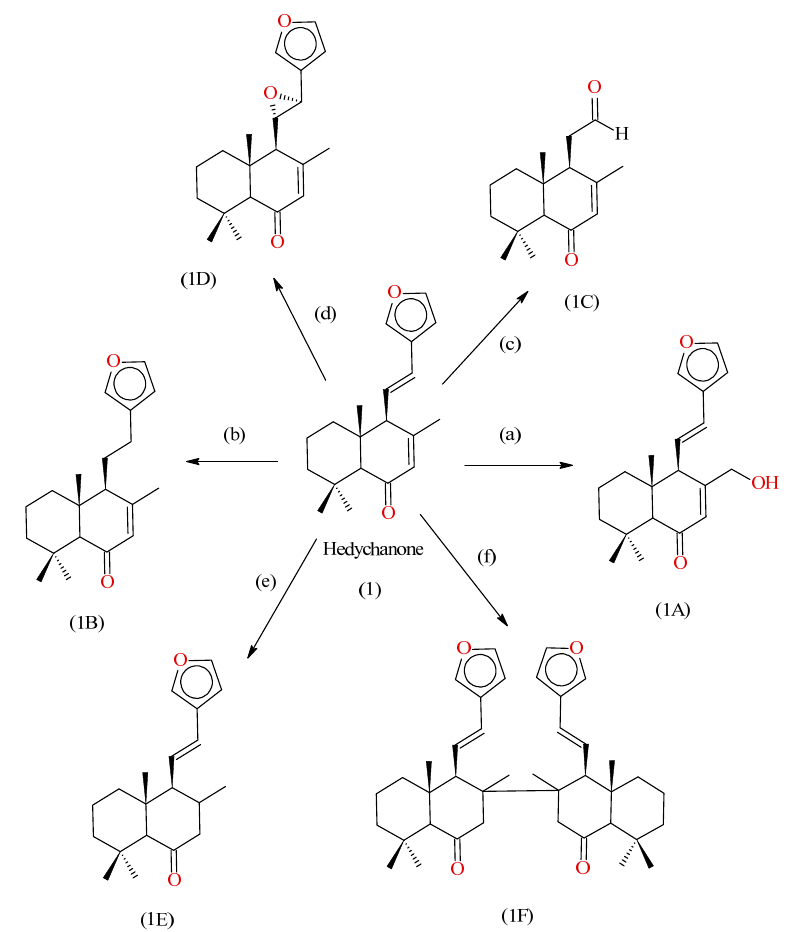
Figure 7. Synthesis of compounds from Hedychenone, reagents and conditions, where (a) SeO 2 , dry Dioxane/reflux, 70 ◦ C, 1 h, 94%; (b) (1) Pd/C (10%), EtOH, 1 h; (2) LiAlH 4 , THF, 0 ◦ C, 4 h, 50%; (c) O 3 , CH 2 Cl 2 , 10 ◦ C, 4 h, 55%; (d) m-CPBA, CH 2 Cl 2 , rt, 2 h, 70%; (e) Pd/C (10%), EtOH, 1 h, 70%; (f) Al-Hg alloy, HCl–MeOH/reflux, 3 h. 1A: Yunnacoronarin D; 1B: 11,12-Dihydrohedychenone; 1C; Aldehyde product; 1D: 11,12-oxidised products; 1E: Hedychenone; 1F: Dimer